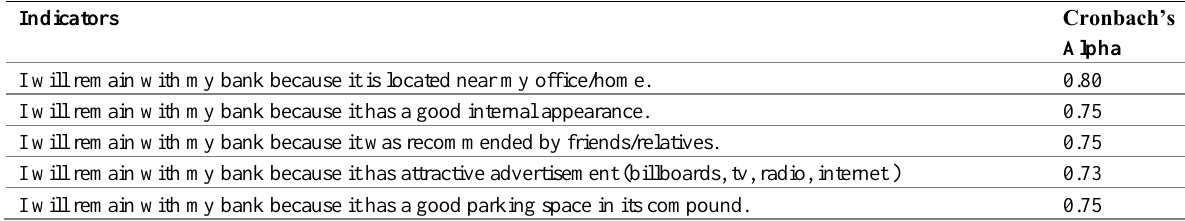
Table 1: All (5) item Cronbach’s alpha reliability score: External